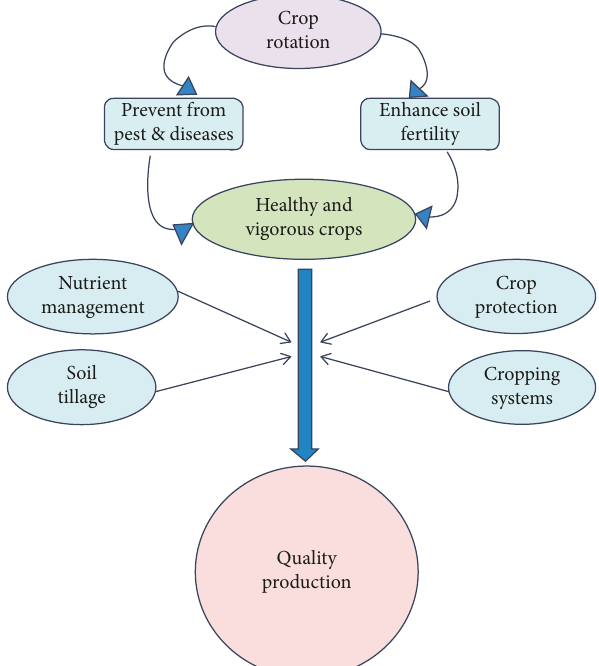
Figure 2: Mixed cropping/intercropping [30].